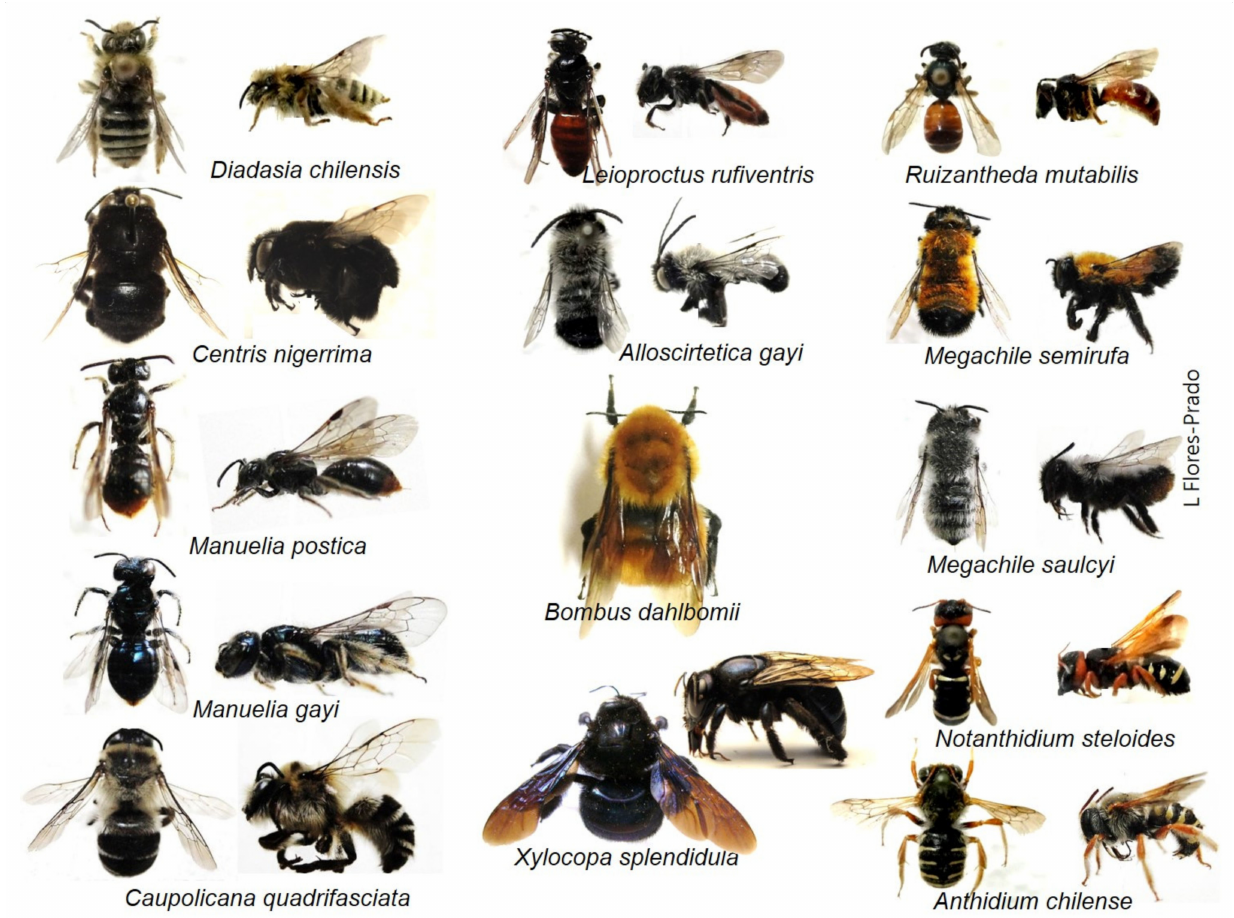
Figure 2. Examples of common bee species in Chile (Photos: Luis